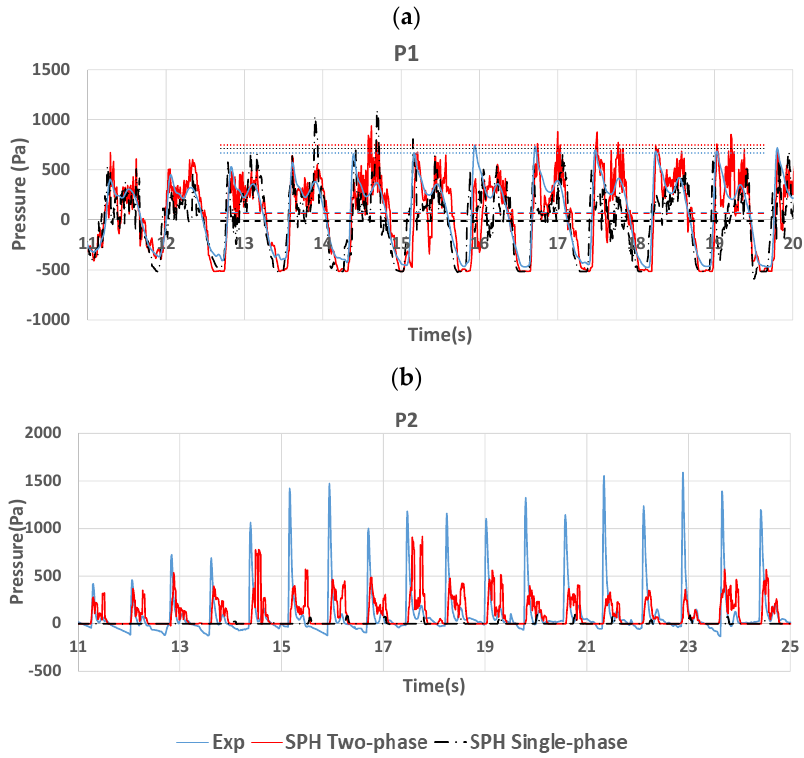
Figure 17. Comparison of pressures at ( a ) P1 and ( b ) P2 under roll oscillation with a filling ratio of 50%.